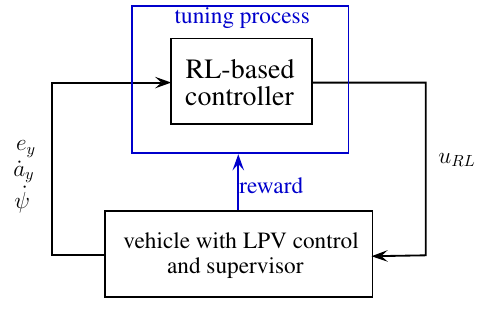
Figure 2. Control structure in the learning